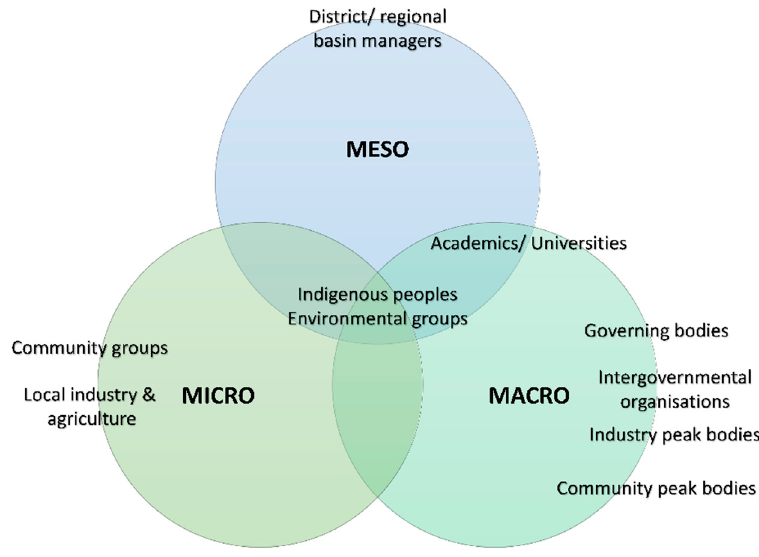
Figure 3. Representation of macro-, meso- and micro-level stakeholder groups.